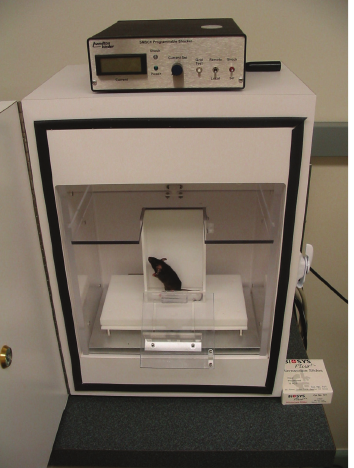
Figure 3: Acoustic startle: the mice are placed on a sensing platform and their response to acoustic stimuli is